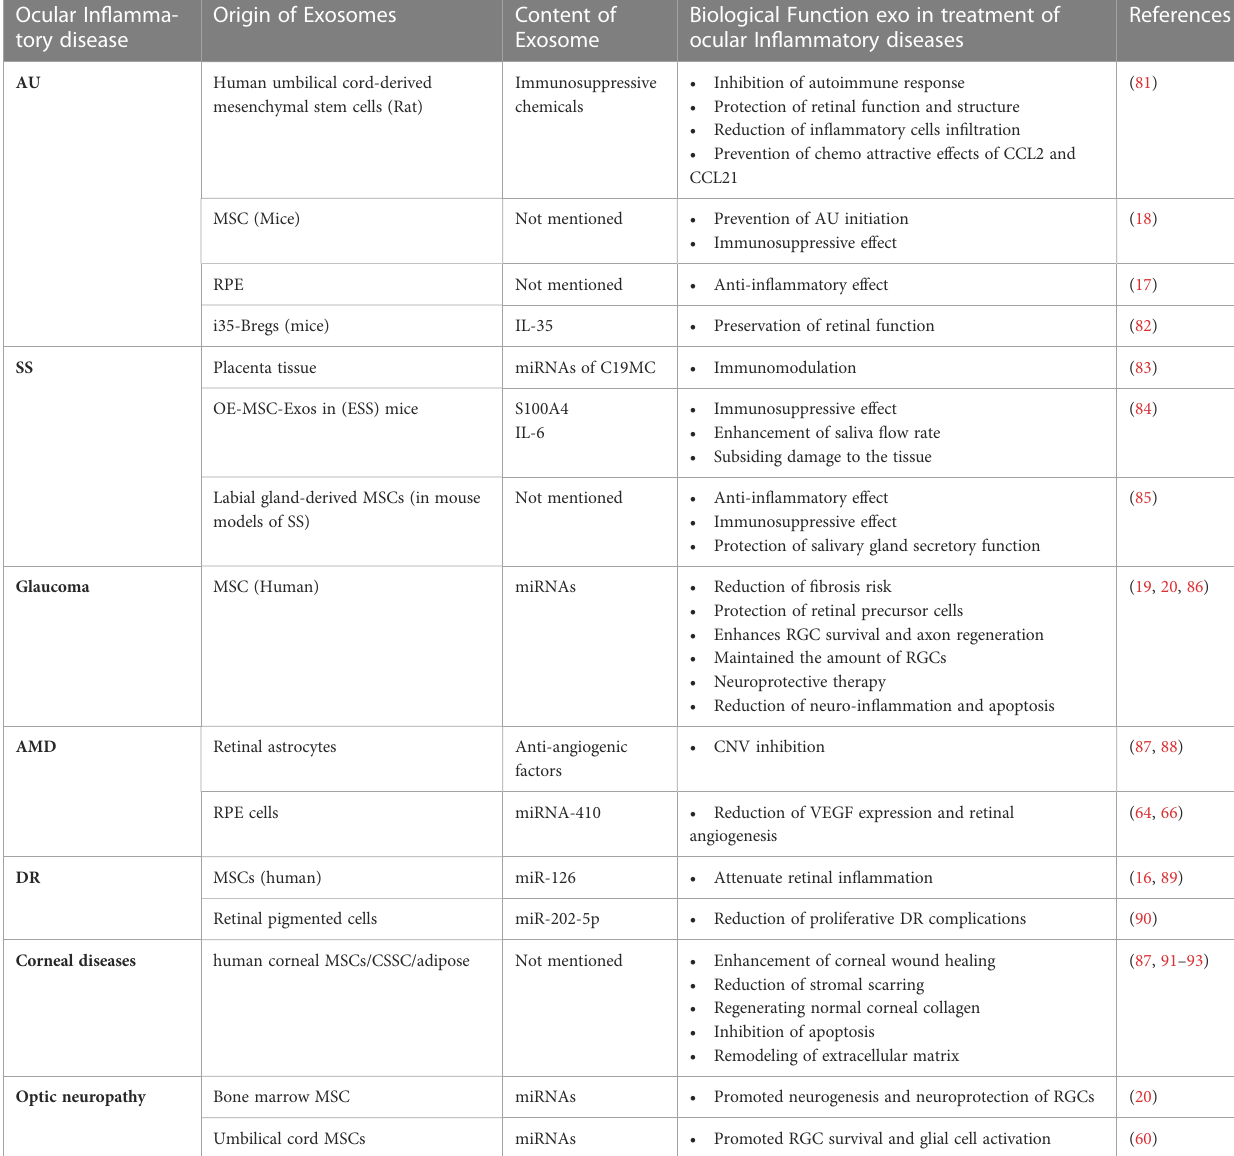
TABLE 2 Biological function of exosomes in the treatment of ocular in fl ammatory